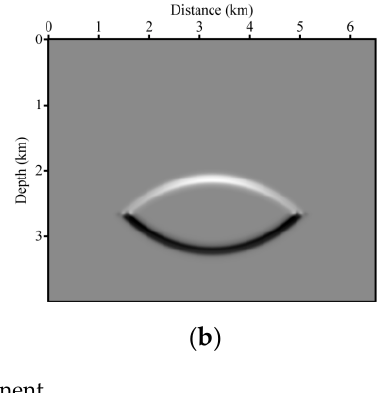
Figure 6. Poynting vector: ( a ) 𝑥 -component; ( b ) 𝑧 -component.